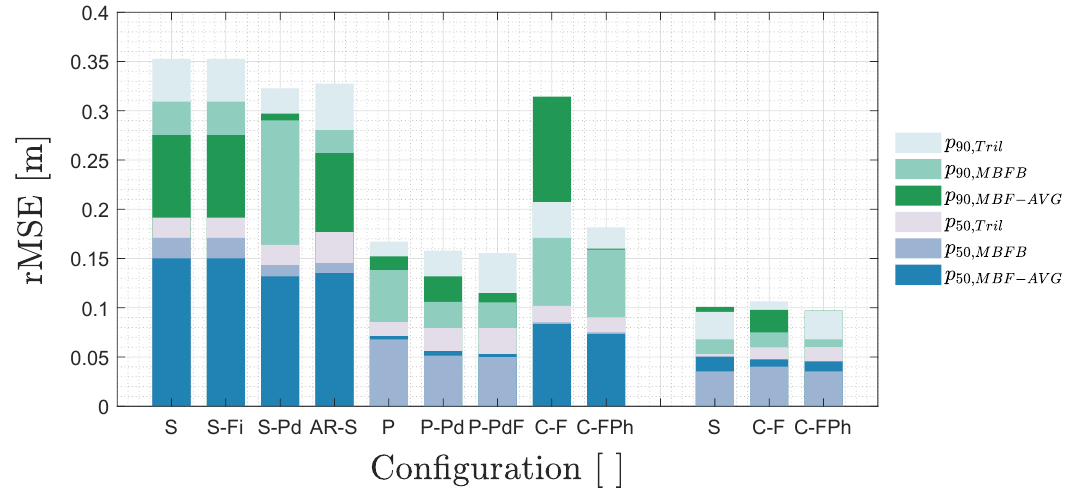
Figure 10. A bar chart representing the p 50 and p 90 for Tril, MBF-AVG and MBFB for various (u)VLP demodulation configurations. The left 9 bars represent uVLP configurations, while the right 3 bars constitute VLP-based demodulation schemes. The etymology of the configuration names is clarified in Figure